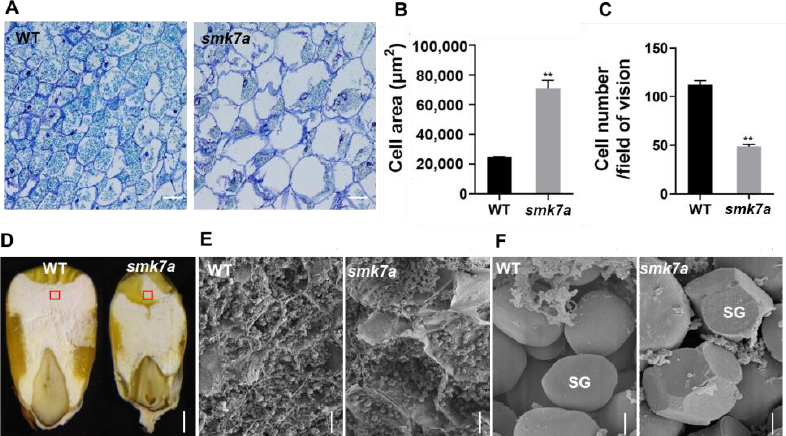
Figure 2. Comparison of the endosperm cells and starch granules in the WT and smk7a . ( A ) Light microscopy observation of the endosperm cells of the WT and smk7a kernels collected at 20 DAP. The scale bar is 100 μm. Comparison of the endosperm ( B ) cell area and ( C ) cell number between the WT and smk7a . The values are the means of the three replicates ± SD. Thirty cells were selected for statistical analysis for each replicate. ** denotes statistical significance at p < 0.01 according to the t-test. ( D ) Longitudinal section of the kernels collected from the WT and smk7a at 34 DAP. The red square indicates the region that was observed via scanning electron microscopy (SEM). The scale bar is 1 mm. ( E ) SEM analysis of the peripheral regions of the WT and smk7a endosperm col- lected at 34 D AP. The scale bar is 100 μm. ( F ) SEM analysis of the starch granules of the WT and smk7a endosperm. SG, starch granule. The scale bar is 10 μm. 2.2. smk7a Mutant Had Lower Starch, Storage Protein, and Free IAA Contents To further determine the underlying biochemical basis for the defective phenotype of the smk7a mutant, we measured the soluble sugar, total starch, and protein contents of the WT and smk7a kernels. Based on our results, the content of the soluble sugars (in- cluding glucose, fructose, and sucrose) of the smk7a kernels was 1.40 – 2.70-fold higher than that of the WT kernels at 12 DAP, and it was 3.72 – 4.07-fold higher at 20 DAP (Figure 3A – C). In contrast, the starch content was significantly lower, i.e., 4.25-fold and 4.67-fold at 12 and 20 DAP, respectively (Figure 3D). In addition, the starch content of smk7a was only 87.8% that of the WT in the mature stage (Figure 3D). We also noticed that the total soluble sugar content of the WT decreased by 40.3% from 12 DAP to 20 DAP, while the starch content increased, which represents the balanced conversion of sugar to starch. However, for smk7a , when the starch content increased, the soluble sugar content also increased by 22.3% from 12 to 20 DAP. These results suggest that the sugar metabolism and starch synthesis were disturbed in the smk7a kernels in the filling stage. Quantitative analysis of the protein contents revealed that the zein protein was also significantly lower in smk7a and was 71.7%, 76.7%, and 94.0% that of the WT at 12 DAP, 20 DAP, and in the mature stage, respectively (Figure 3E). IAA has been reported to play an important role in kernel development. We com- pared the free IAA contents of the WT and smk7a at 12 and 20 DAP. Based on our UHPLC-ESI-MS/MS analyses, the free IAA content of smk7a was 58.3% and 83.2% that of the WT at 12 DAP and 20 DAP, respectively (Figure 3F). These results suggest that IAA synthesis was suppressed in smk7a in the early development stages.